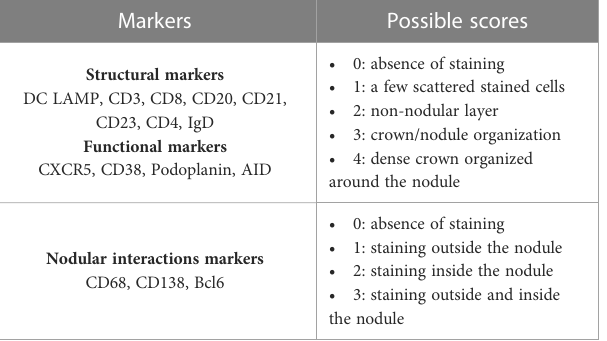
TABLE 3 Criteria used for the pathological assessment of germinal center markers on imaging mass cytometry images. Markers Possible